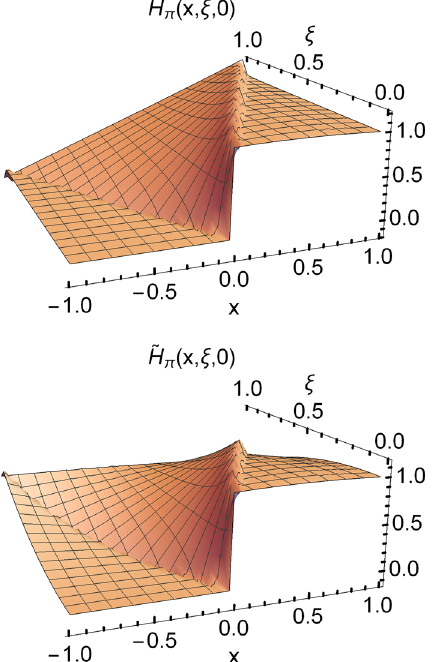
Fig. 2 H π ( x ,ξ, t = 0 ) , twist-two vector GPD: upper panel – Eq. (41); andlowerpanel–Eq.(41)amendedthroughadditionofEq.(46).Owing to Eq. (44), we only plot ξ > 0